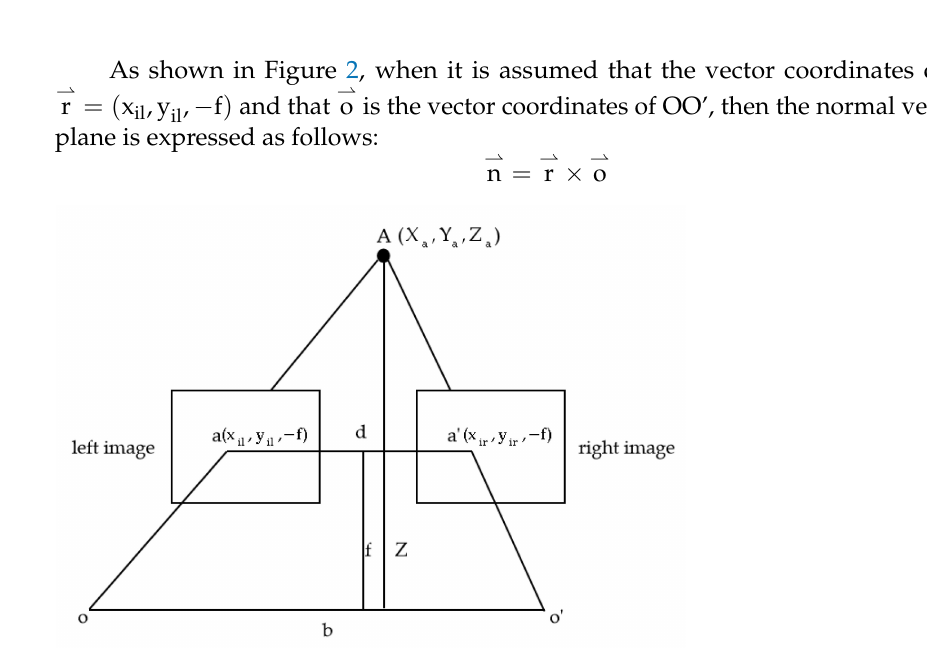
Figure 2. Schematic diagram of the principle of image